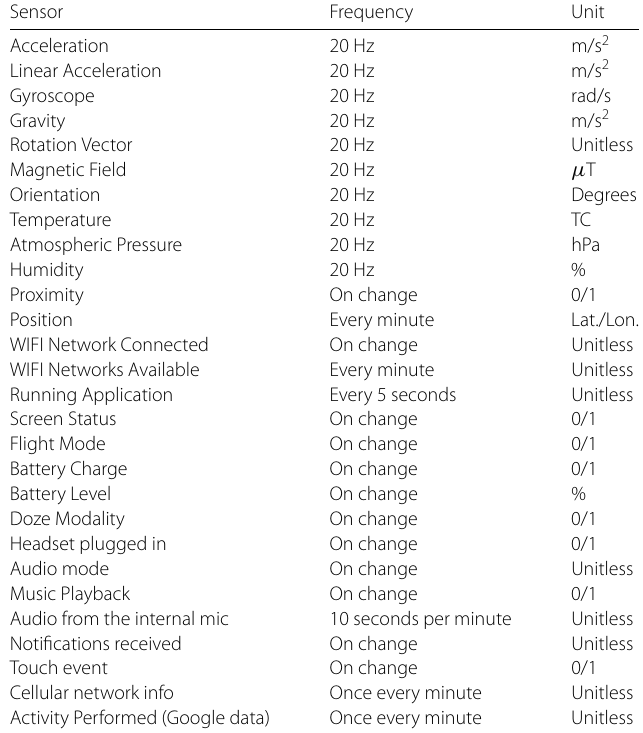
Table 1 List of sensors. Proximity triggers when the phone detects close objects, like the subject’s hand or